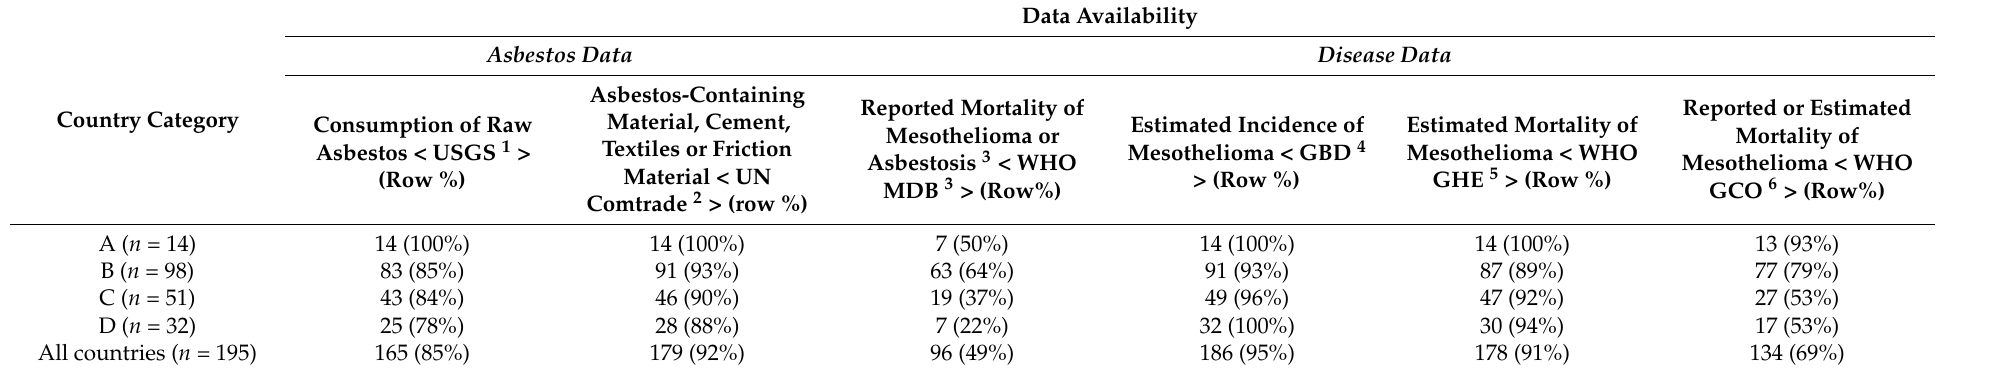
Table 4. Availability of data that can be used for NAPs in public